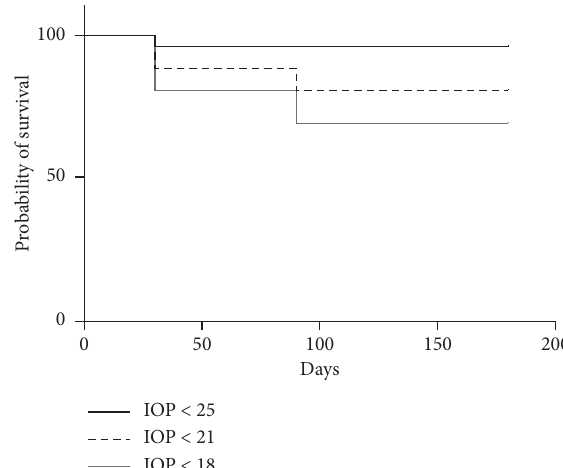
Figure 3: Kaplan–Meier survival curves plotting the cumulative probabilities that the IOP remains below 25mmHg, 21mmHg, and 18mmHg, respectively, following the SLT